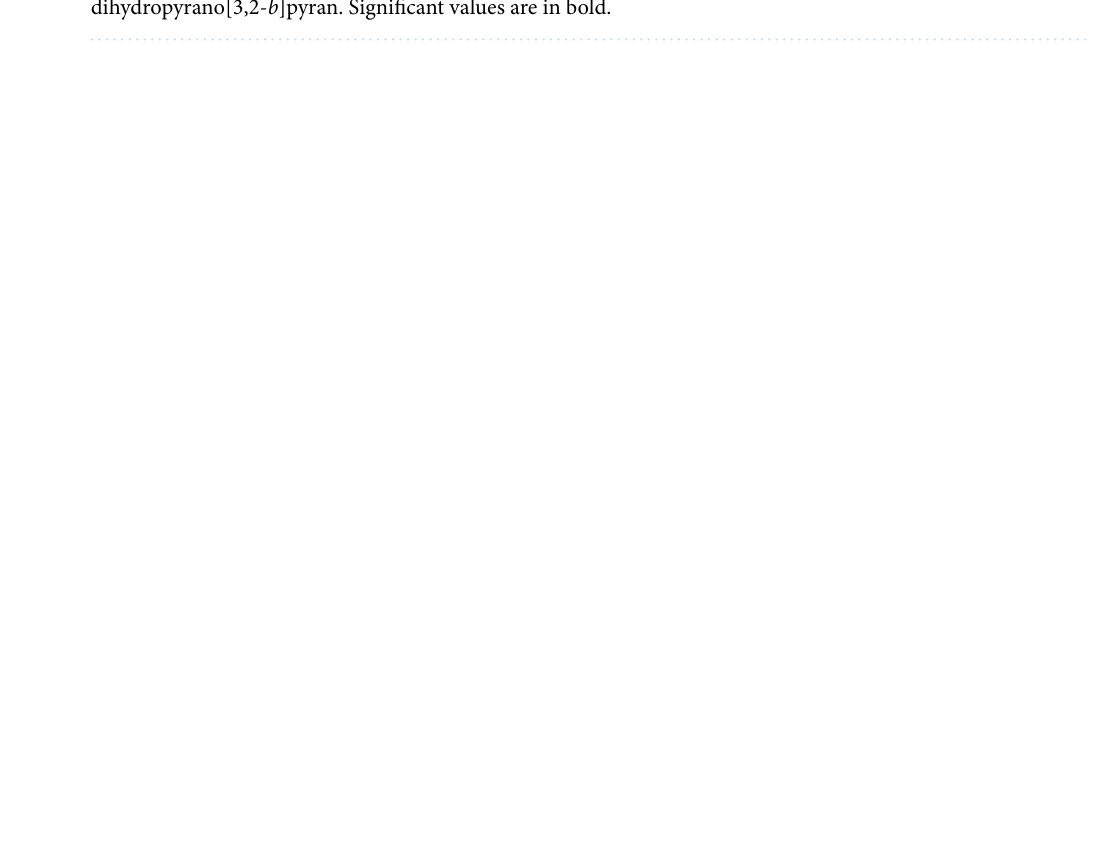
Table 2. Effect of different amounts of catalysts, temperature and solvent (5 mL) in the triazole- dihydropyrano[3,2- b ]pyran. Significant values are in